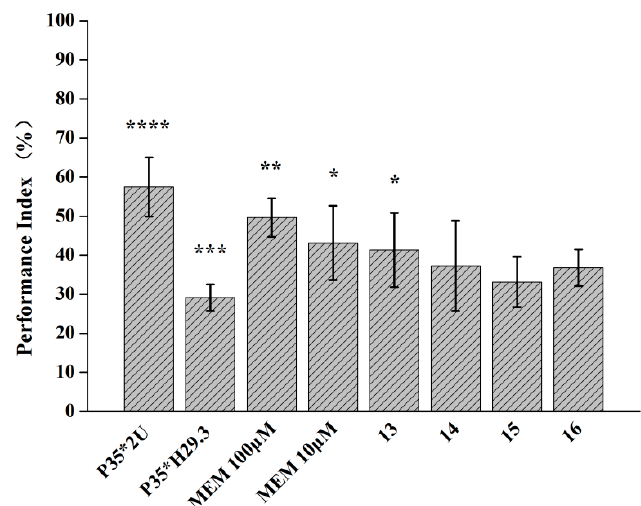
Figure 1. Differential effects of compound 3 and compounds 13 – 16 on rescuing memory deficit on a Drosophila Alzheimer’s disease (AD) model at 10 µ M. The data are shown as means ± SD and analyzed by one-way ANOVA; * p <0.05; ** p < 0.01; *** p < 0.001; n ≥ 20. MEM = memantine.